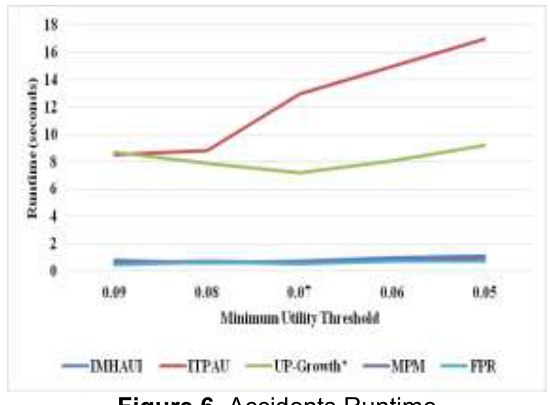
Figure 6. Accidents Runtime